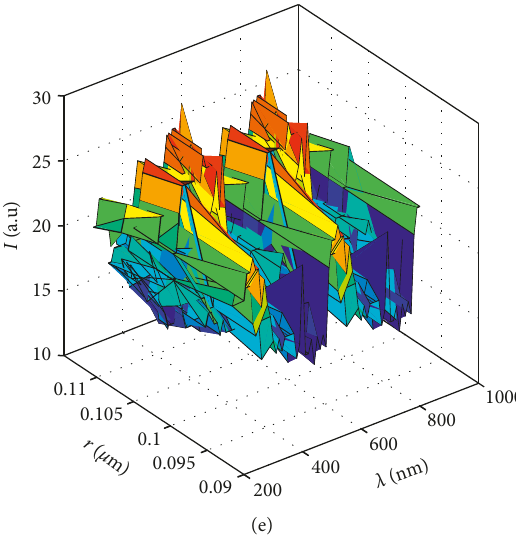
Figure 4: Three-dimensional plots of pixel intensities/a.u (represented as I ) and radii/ μ m (represented as r ) against spectral range/nm (represented as λ ) of multispectral images in the scattering mode for (a) uninfected RBCs ( u -RBCs) and Plasmodium falciparum -infected RBCs ( i -RBCs) of parasite density (PD) (b) (+), (c) (++), (d) (+++), and (e)